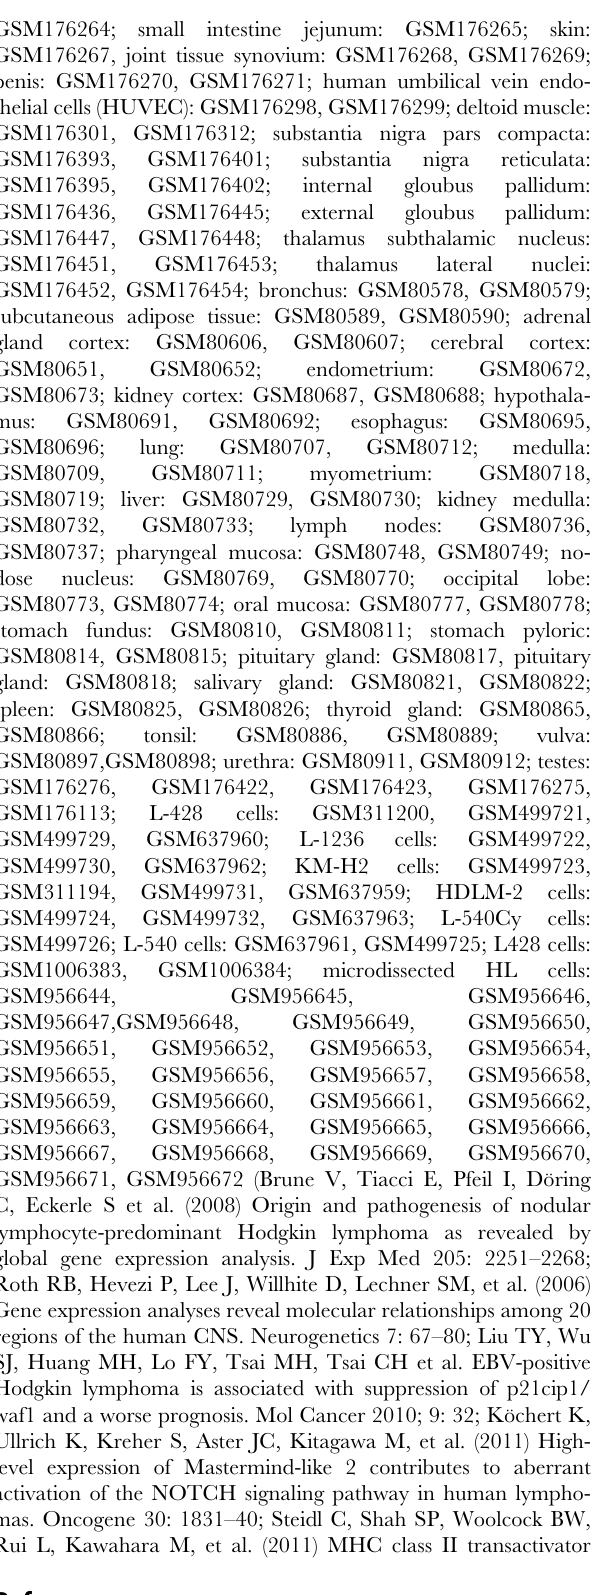
Figure S4 Sequence alignment of DUSP5 and DUSP5 pseudogenes. DUSP5 pseudogenes were identified by a BLAST search using DUSP5 RNA as query. Presented is a sequence alignment of DUSP5 RNA, the genomic DUSP5 DNA, the genomic DUSP5P1 DNA and 3 newly identified DUSP5 pseudogenes (DUSP5P2, DSUP5Psi3, DSUP5Psi4). The present-